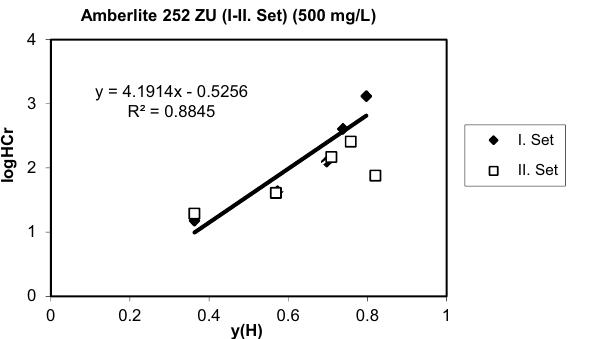
Figure 7. Generalized separation factor for the exchange of H + for Cr 3+ (Initial conc.and pH: 25.975 meq/L, 2.92).